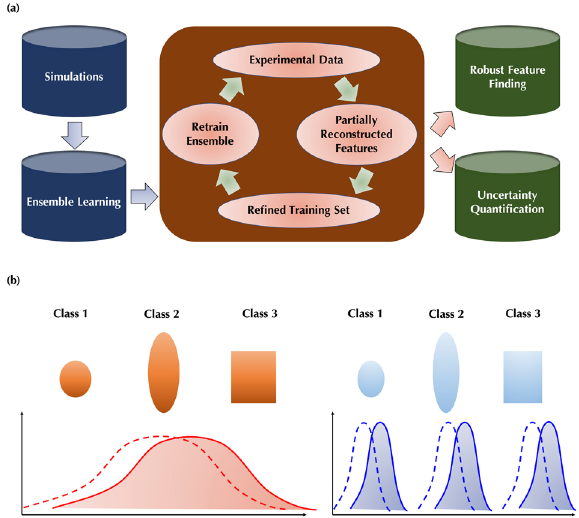
Fig. 2 ELIT framework. High-level schematic of the ELIT approach is shown in ( a ). b In a classically trained network, the training set must be broad enough to allow suf fi cient variability to detect classes 1 and 2 present in the system. However, a suf fi ciently broad training set will also potentially misidentify physically impossible class 3, leading to the classical balance between over- and under fi tting. In the ELIT work fl ow, the multiple trained networks are used to identify the features present in the system, and retrain the network using these features. This allows ‘ focusing ’ the attention of the network on the classes present in the system, thus dramatically improving the